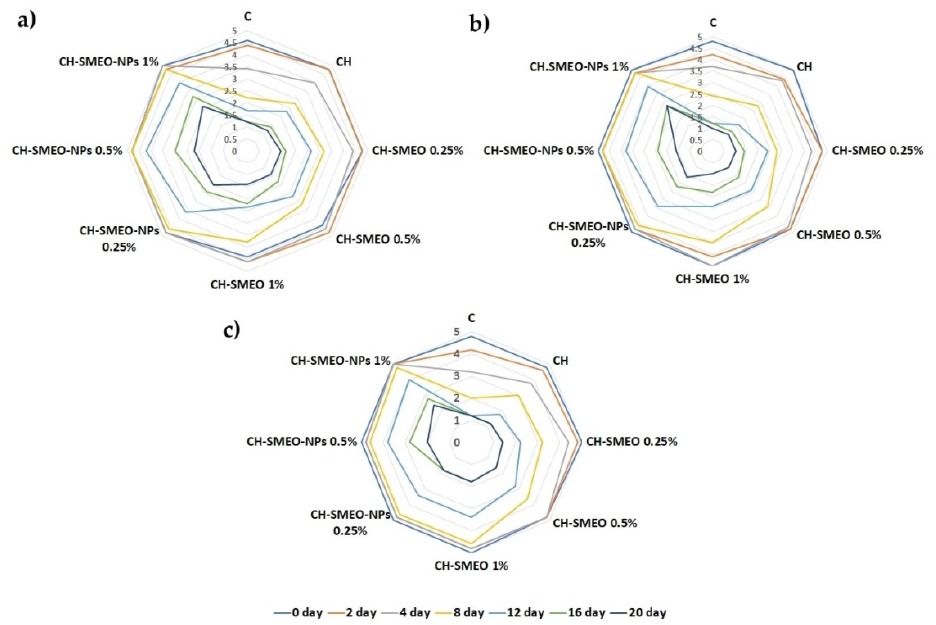
Figure 1. Sensory evaluation of beef samples treated with chitosan coatings and chitosan-based nanoparticles enriched with Satureja montana L. essential oil during storage: ( a ) odor; ( b ) color; ( c ) overall acceptability. CH—chitosan coating; CH-SMEO—chitosan coating enriched with of Satureja montana L. essential oil in different concentrations; CH-SMEO-CNPs—chitosan coating enriched with different concentrations of chitosan-based nanoparticles loaded with Satureja montana L. essential oil; C—control sample.